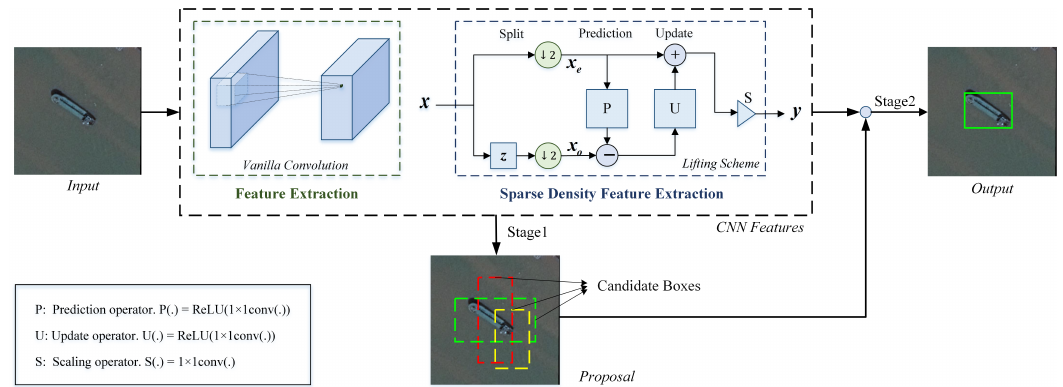
Figure 3. Two stage detection network flowchart based on lifting scheme layer. Different from the existing two-stage detection networks, the lifting scheme layer is used as the sparse density feature extraction module in the backbone CNN, which is superior to the frequently used strided convolution in detection precision. A series of candidate boxes are generated in the first stage, and then they are classified in the second stage. The candidate box that is classified as a ship and exceeds the IOU threshold is reserved in the